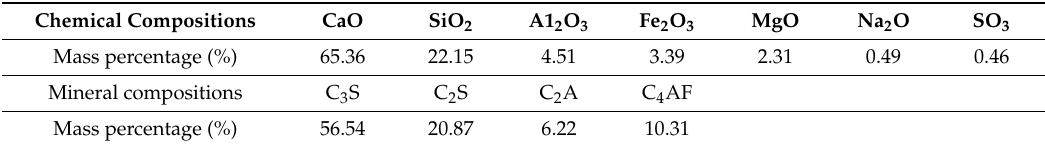
Table 1. Chemical and mineral composition of